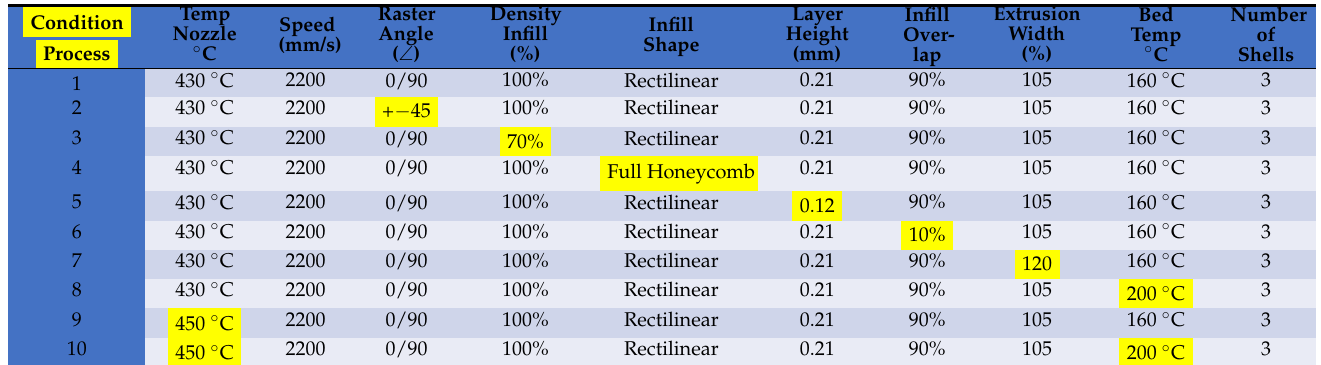
Table 2. The highlighted parameter is the only one changed for ten experimental process conditions. The first process condition is conducted with optimal